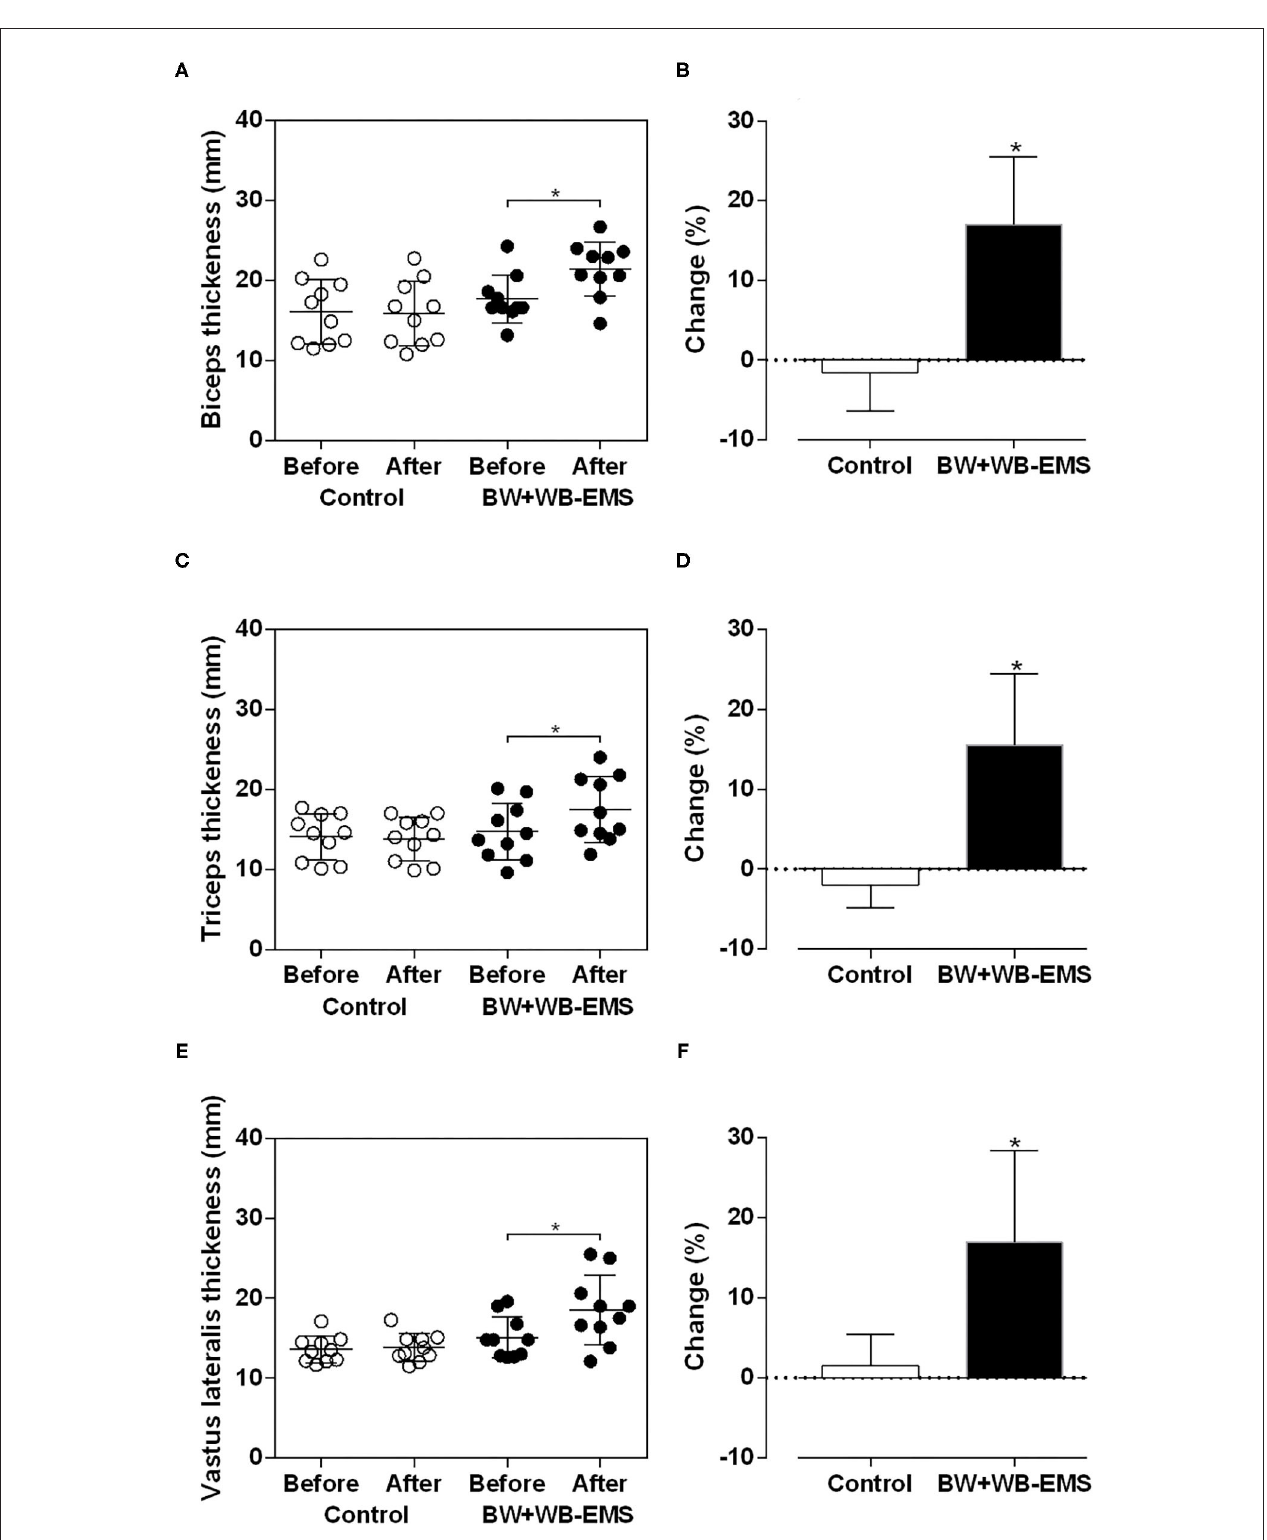
FIGURE 3 | Values expressed as means ± standard deviations of muscle thickness after six weeks of training in control and body weight + whole body electrostimulation (BW + WB − EMS) groups to biceps brachii (A,B) , triceps brachii (C,D) and vastus lateralis (E,F) . *Significantly different from pre-training ( p < 0.05).